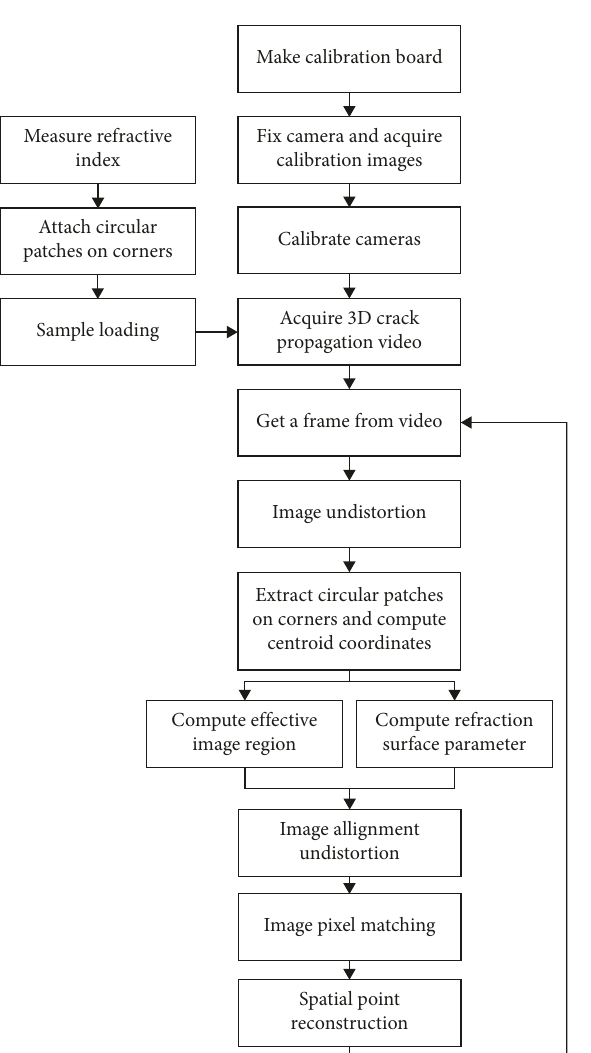
Figure 3: The flowchart of the 3D crack rebuilding